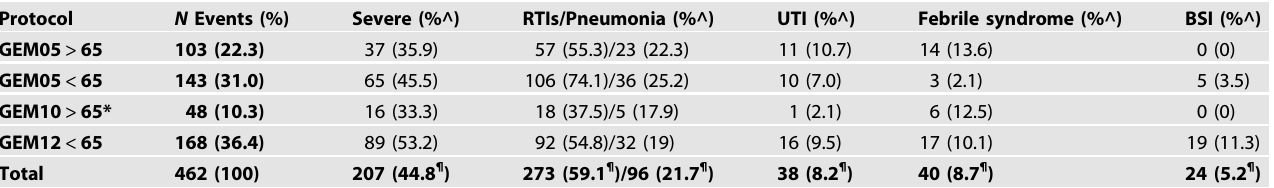
Table 2. Rate of any-grade and severe infection by clinical trial, by most frequent type of infections in the fi rst 6 months. Protocol